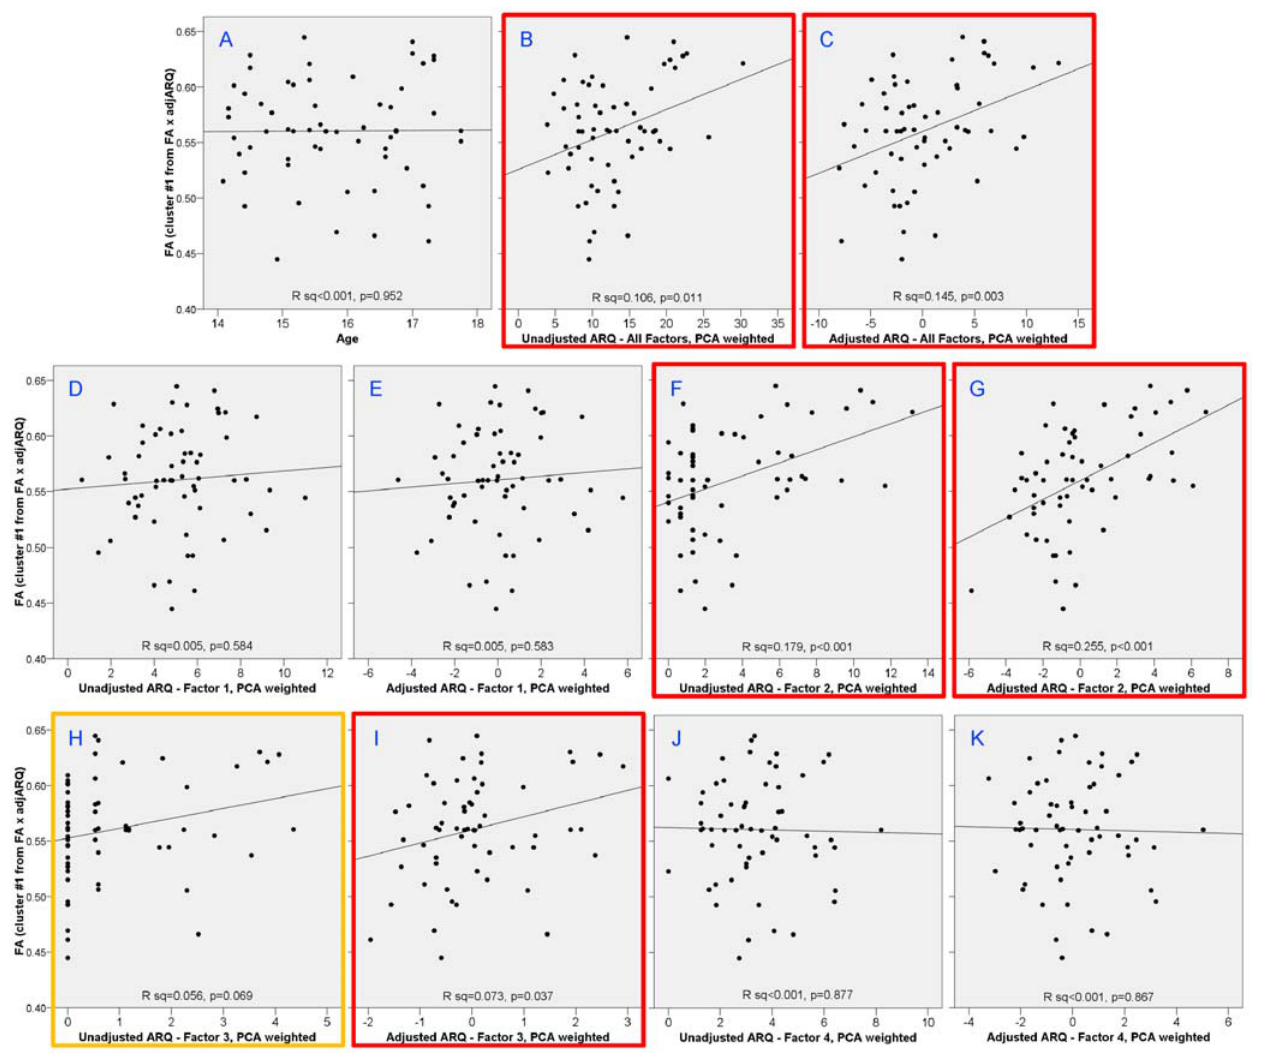
Figure 5. Correlations with FA in right superior corona radiata cluster with age and different factors of the ARQ. Age was uncorrelated with TD in this region (A). Total ARQ was significantly correlated with TD both before (B) and after adjusting ARQ for sex and age (C). Analysis of the subfactors showed that this correlation was driven predominately by factor 2 – rebelliousness (F and G) and slightly to factor 3 – recklessness (H and I).